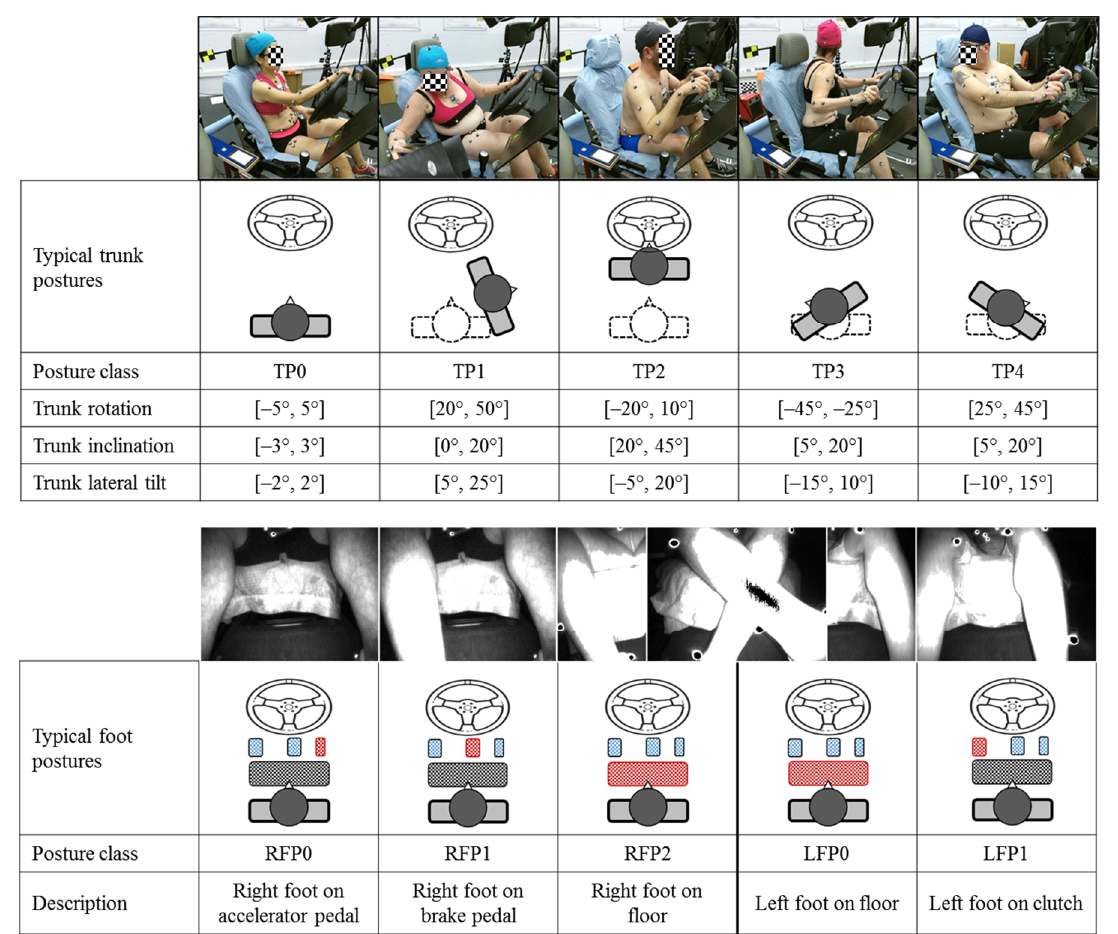
Figure 3. Definition of posture classes for trunk, right foot, and left